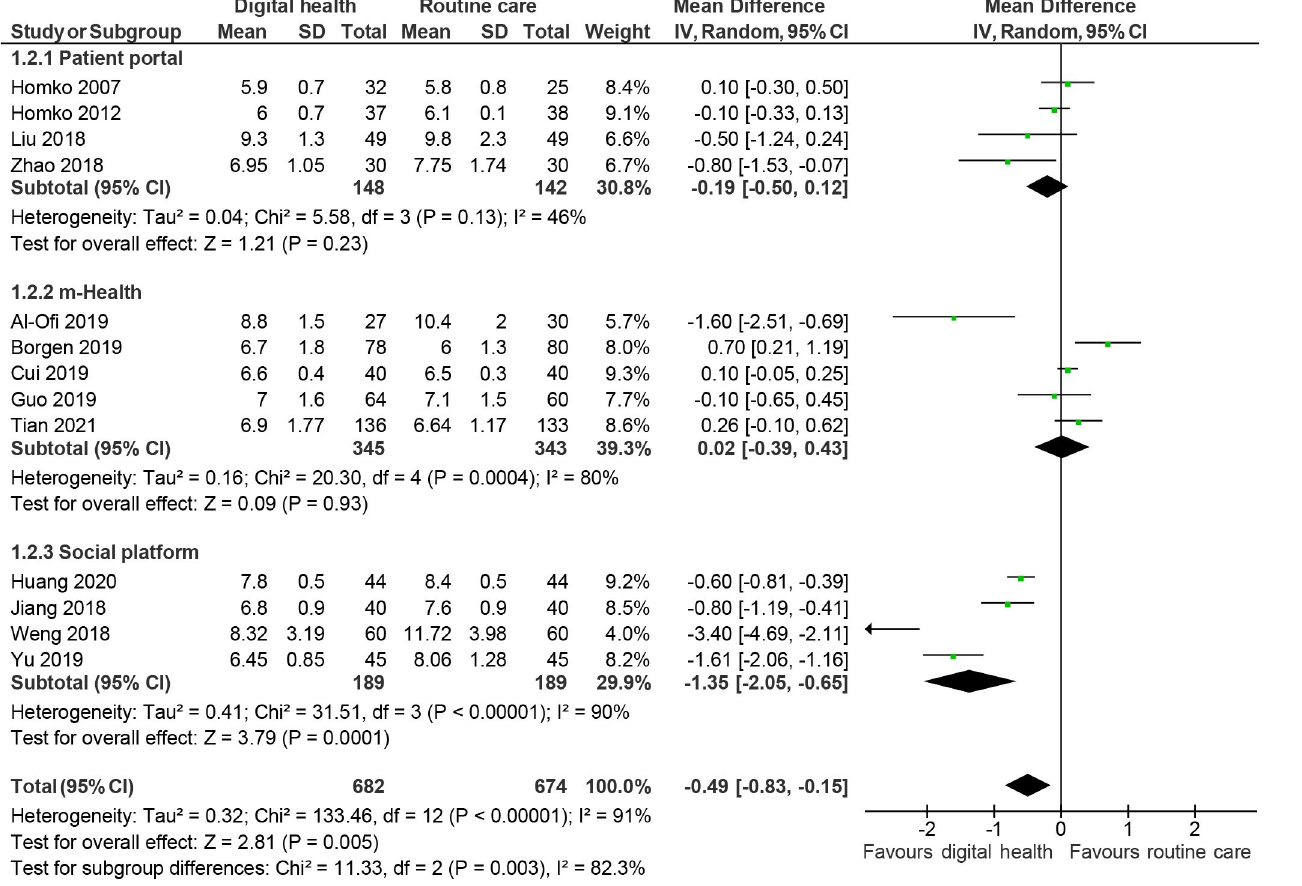
Fig 3. Random effects meta-analysis of the mean difference in 2-hour post prandial glucose (mmol/L), comparing digital health interventions or routine care.